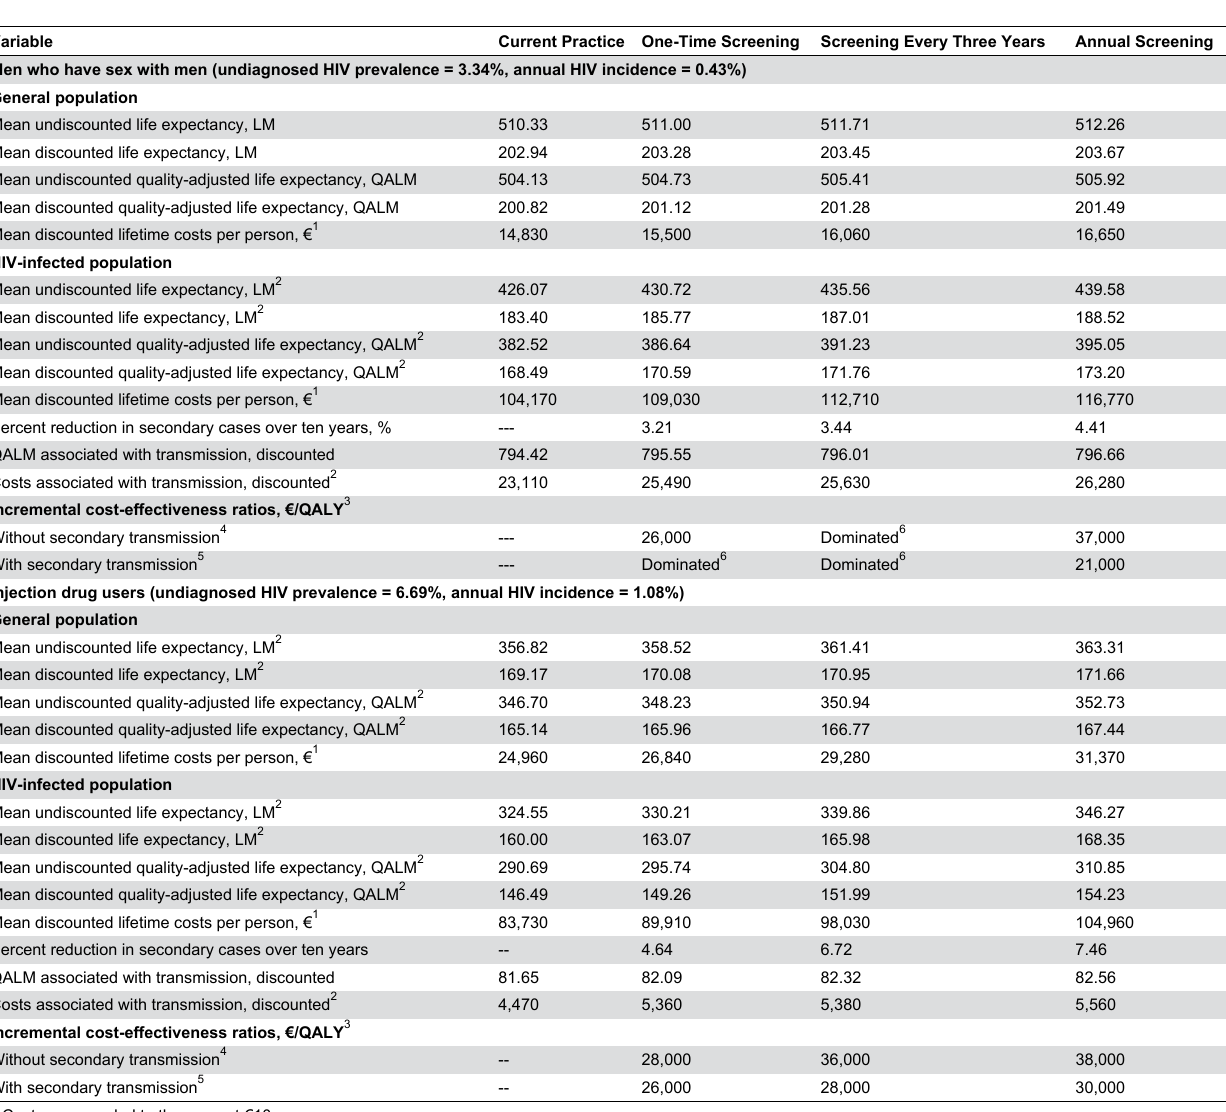
Table 4. HIV Screening in High Risk Groups in Portugal.